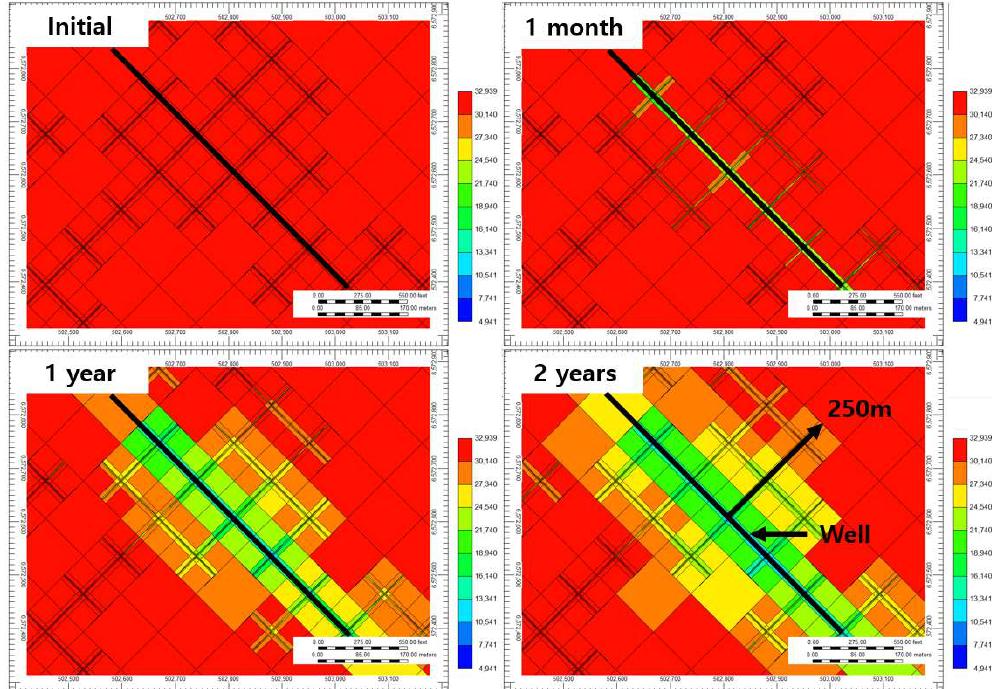
Figure 14. Pressure propagation over time. (Colors of the grids indicate the fluid pressure (kPa)).